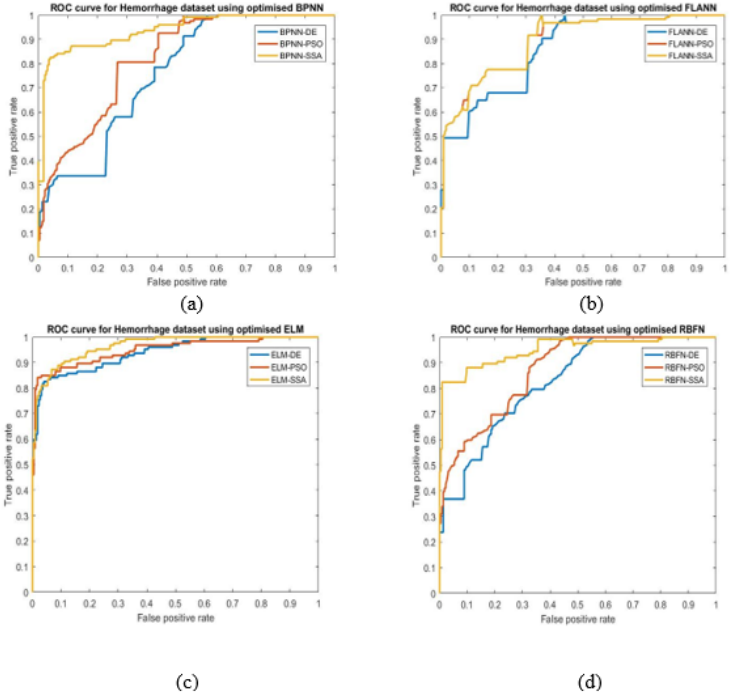
Figure 12. Comparison of ROC plots for Hemorrhage dataset using classifiers ( a ) BPNN, ( b ) FLANN, ( c ) ELM, or ( d ) RBFN.